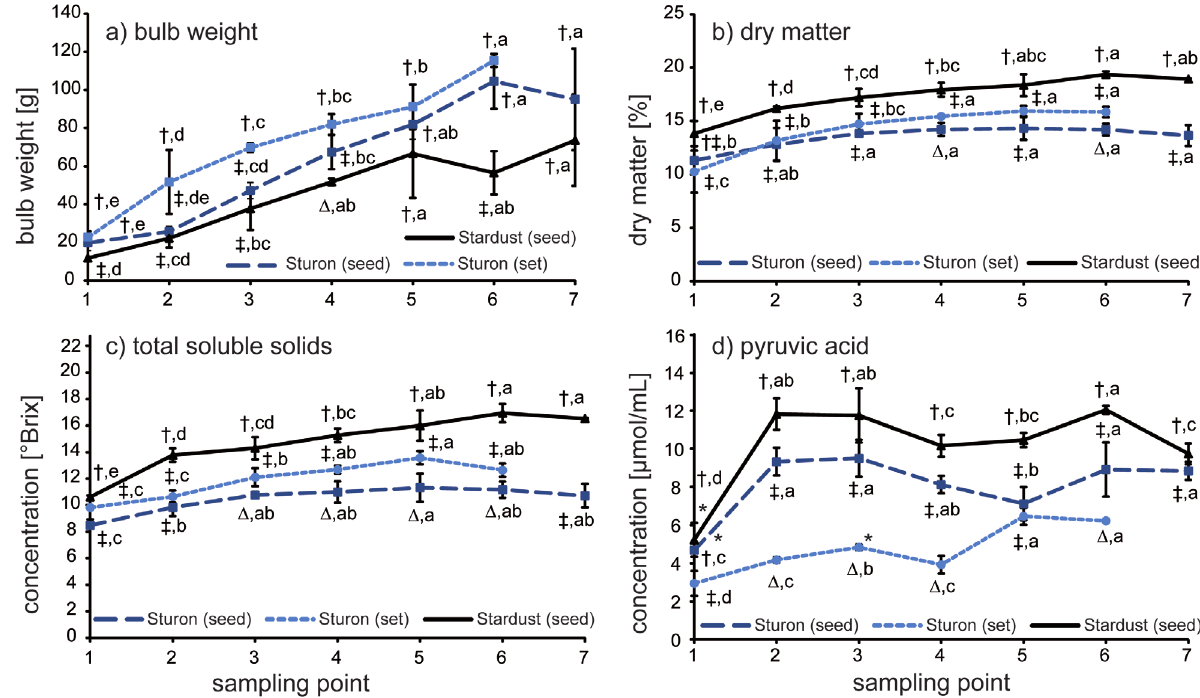
Fig. 1: Bulb weight (a), dry matter (b), total soluble solids (c) and pyruvic acid (d) concentrations in onion samples of different stages of maturity and of different cultivars, i.e. ‘Sturon’ (grown from sets), ‘Sturon’ (grown from seeds) and ‘Stardust’ (grown from seeds). Timing of the second fertilization is indicated by asterisks (*). Sampling point 1 represents the time point when first signs of bulb development were observed. Subsequent time points represent weekly sampling intervals, continued until leaves had fallen, i.e. until regular harvest of onions. On each sampling date, samples of five maturing onion bulbs were collected from 3 parcels per variant, i.e. 15 bulbs per sampling date and variant. Symbols †, ‡ and ∆ indicate significant differences of means ( p < 0.05) between individual variants Sturon (grown from seeds), Sturon (grown from sets) and Stardust (grown from seeds) at different sampling points. Different letters (a, b, c, d, e) indicate significant differences of means ( p < 0.05) within individual variants, sampled at different stages of